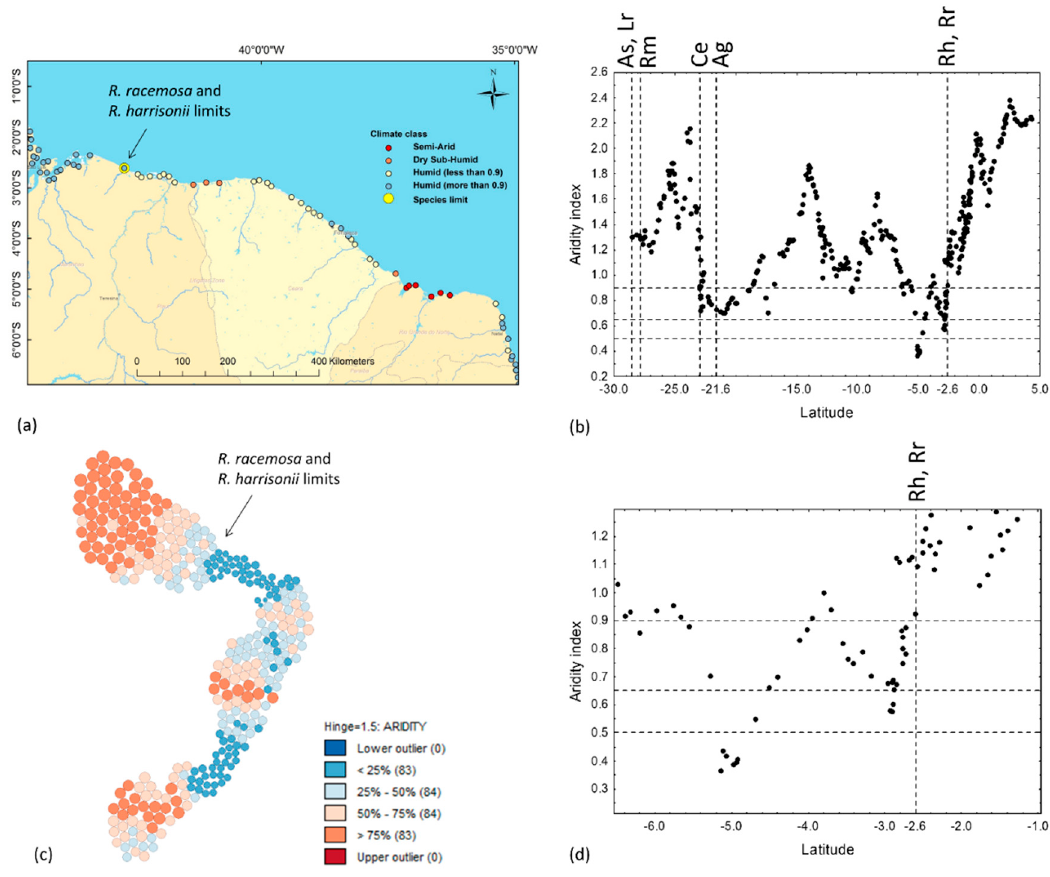
Figure 9. Detailed description of the Aridity index for mangroves in Brazil. ( a ) Detail spatial distribution map of the northeast limits with their Aridity values for each location of mangroves; ( b ) Scatterplot ( n = 334) representing the aridity by latitude in decimal degree superimposed on species distribution limits of (vertical dashed lines); ( c ) Cartogram map distorted by the high and low values of aridity index; ( d ) Scatterplot of aridity with a detailed zoom on the surrounding of the northeast species distribution limits (vertical dashed lines of the species limits). The horizontal dashed lines in the aridity index indicate the climate class (0.2–0.5—Semi-Arid; 0.5–0.65—Dry Sub-humid; >0.65—Humid) [3], and we included an additional dashed line at aridity index 0.9, because as shown in ( a ) the two species of Rhizophora reach their southernmost limit around that value. Refer to Figure 5 for further explanations.